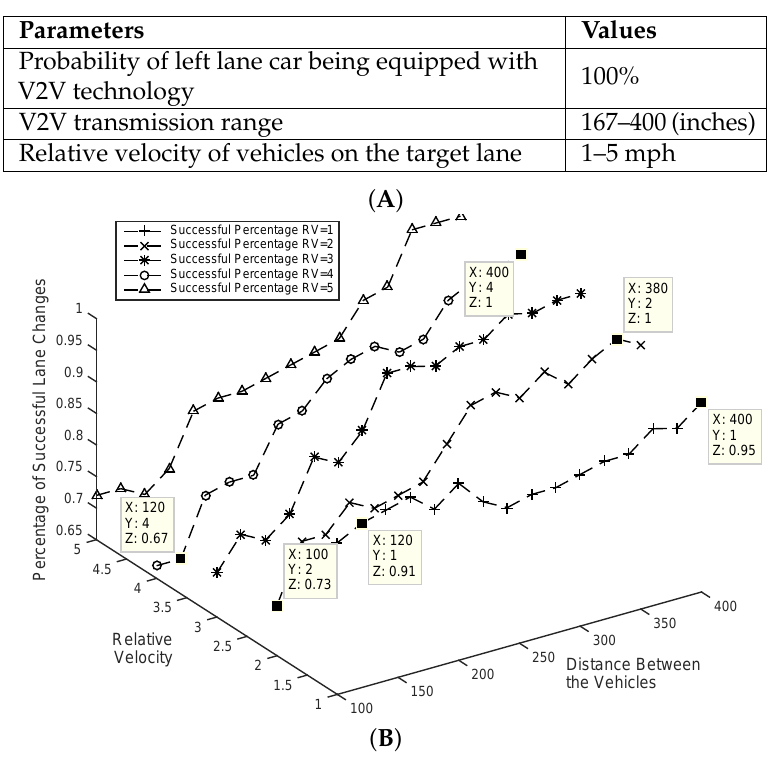
Figure 5. ( A ) experimental parameters; ( B ) the impact of relative velocity and vehicle-to-vehicle (V2V) transmission range on the rate of successful lane